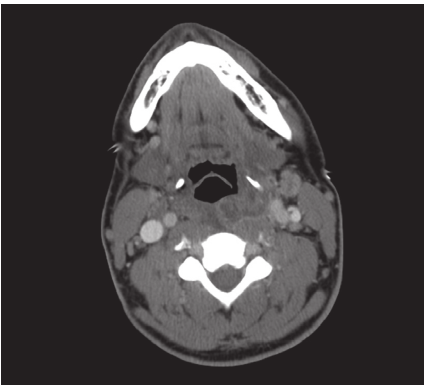
Figure 1: Horizontal section of neck computed tomography (CT) with contrast showing retropharyngeal and bilateral peritonsillar multiloculated enhancing fluid collections in addition to throm- bosis of the left retromandibular vein and punctate foci within the left internal jugular vein.